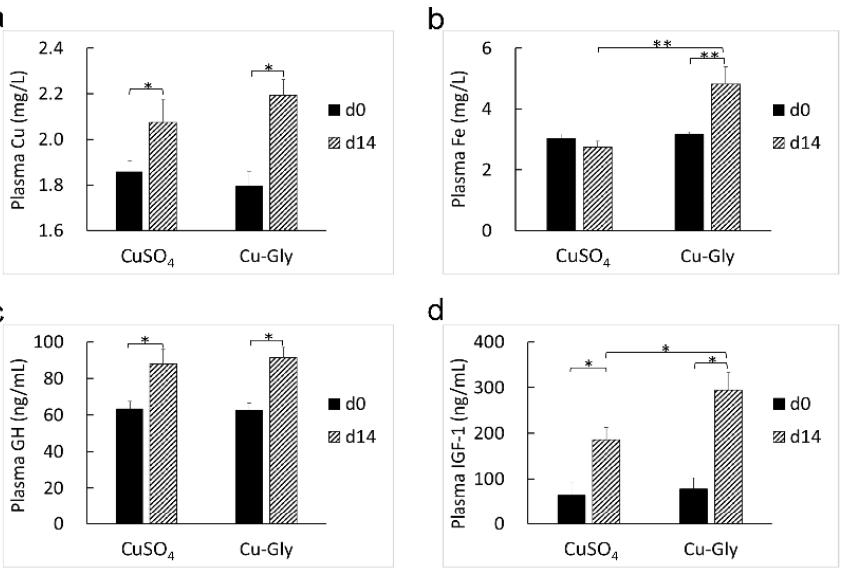
Figure 2. Effects of Cu sources on the levels of plasma Cu, Fe, GH, and IGF-1. Concentrations of plasma Cu ( a ), Fe ( b ), GH ( c ), and IGF-1 ( d ). Data present mean values ± standard errors. * represents a significant difference at p < 0.05, and ** represents a significant difference at p < 0.01. n = 6. GH, growth hormone; IGF-1, insulin like growth factor 1. As compared to the baseline (d0), the supplementation of CuSO 4 and Cu-Gly increased the plasma GH ( p = 0.022, 0.018. Figure 2c) and IGF-1 levels ( p = 0.030, 0.012. Figure 2d) at the end of the experiment. The Cu-Gly group had a higher plasma IGF-1 level ( p = 0.039) than the CuSO 4 group at the end of the experiment. Moreover, there was no difference in the plasma GH level between the CuSO 4 and Cu-Gly groups. 3.3. Fecal Microbiome A total of 1280355 valid reads obtained from 24 samples were assigned to 1185 operational taxonomic units (OTUs) at the 97% similarity level. Rarefaction curves of the Sobs, Shannon, and Simpson indexes revealed a sufficient sequencing and sample size, and most diversity was captured. As shown in the Venn diagram (Figure 3a), the numbers of OTUs in the CuSO 4 (1021 OTUs) and Cu-Gly groups (1053 OTUs) were reduced by 5.20% and 4.01%, respectively, as compared with the baseline (1077 OTUs for CuSO 4 and 1097 OTUs for Cu-Gly).